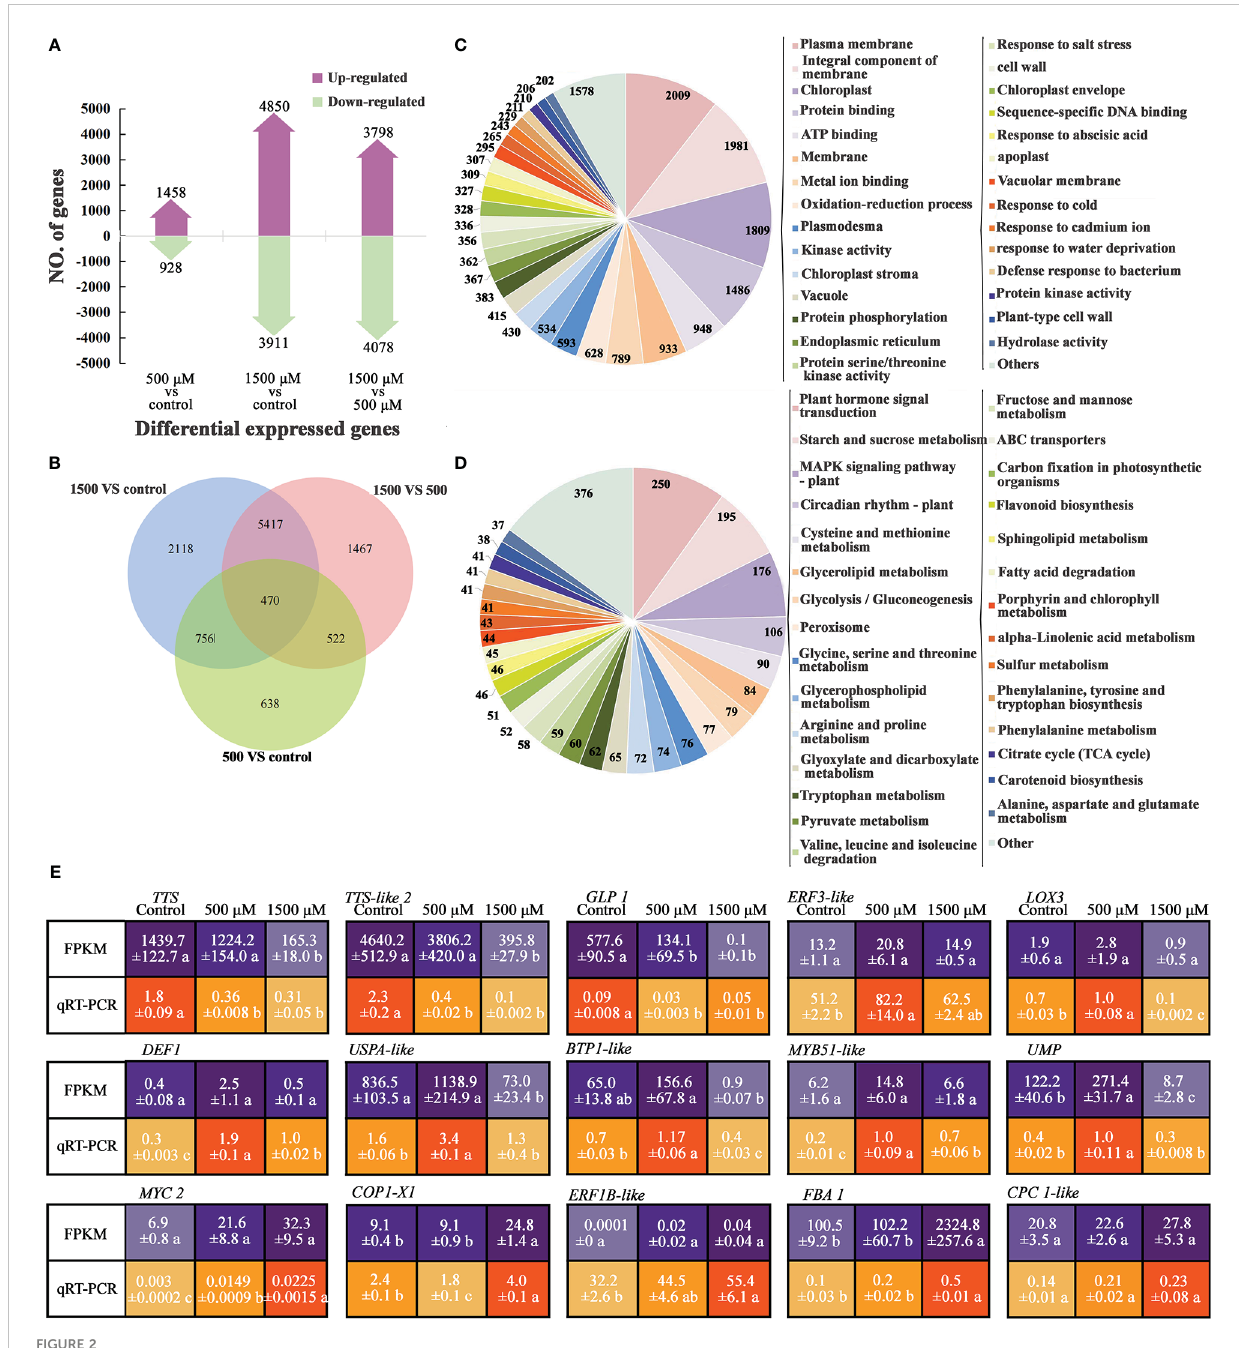
FIGURE 2 Analysis of DEGs by RNA-seq and qRT-PCR of MT treated radish “ JNYB ” . (A) Numbers of genes up- and down-regulated of contrast sets of 500 m M MT treated group VS control, 1500 m M MT treated group VS control and 1500 m M VS 500 m M MT treated groups; (B) Numbers of DEGs of comparison sets. The Venn diagrams depict the number of DEGs for each comparison with the numbers in the overlapped area representing the number of genes shared for the comparison; (C, D) DEG functional annotation (top 30) by GO classi fi cation and KEGG pathway analysis; (E) Veri fi cation of selected DEGs using qRT-PCR; the relative expression level of a gene was determined using a 2 - △△ Ct method; values presented are means ± SE; signi fi cant difference at P < 0.05 relative to the control is indicated by lowercase